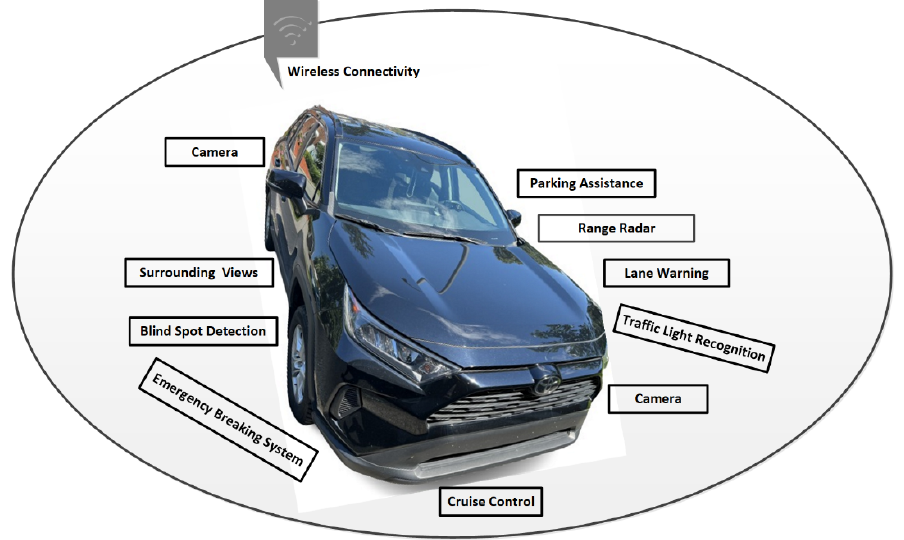
Figure 1. Modern Vehicular Technologies.